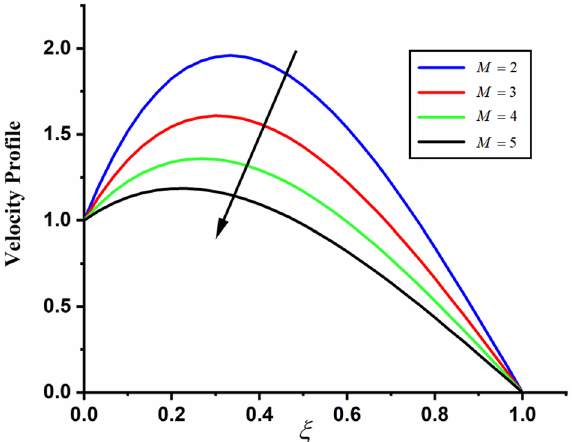
Figure 7. The impact of M on fractal-fractional couple stress fluid velocity in channel when, α = 0.5 , β = 0.5 , Gr = 2 , Gm = 3 , K = 3 , η A = 1 , P = 1.5 , Pr = 1.5 , Re = 2.5 and Sc = 0.3 .